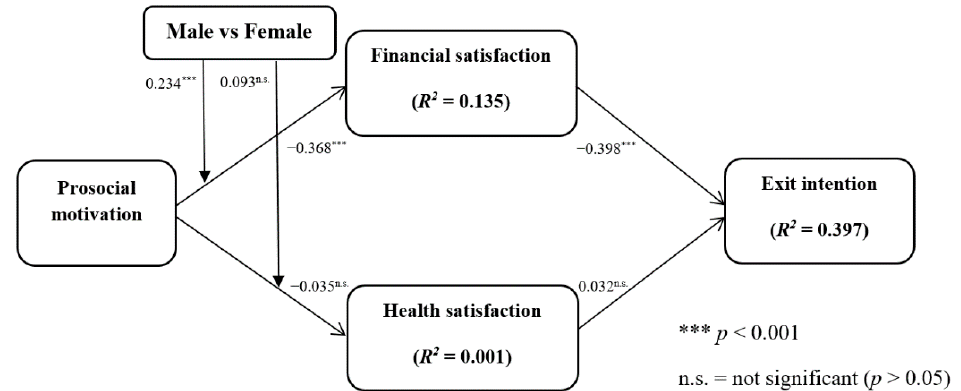
Figure 2. Path coefficients and R 2 of the inner model.